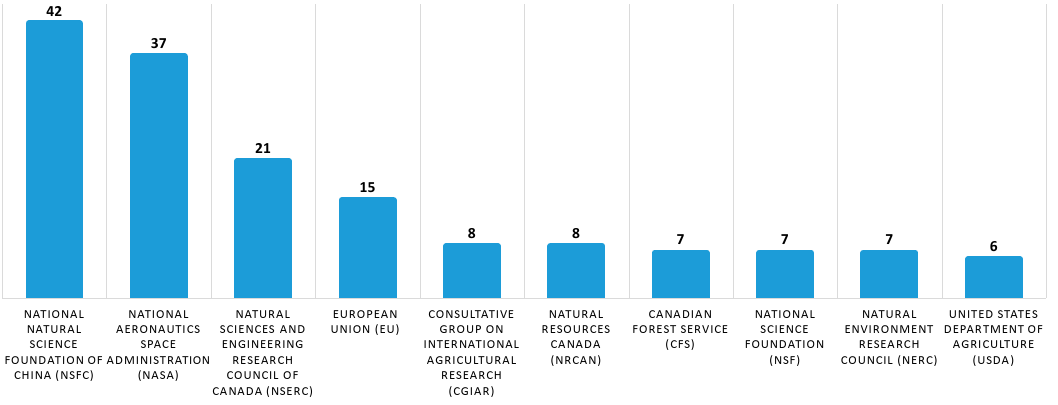
Figure 8. The number of times cited the published articles per year for terrestrial, aerial, and satellite- based systems. The analysis was performed for forest fire detection in the imaging research area. Data retrieved from Web of Science [134] for dates between 1990 to October 2020.